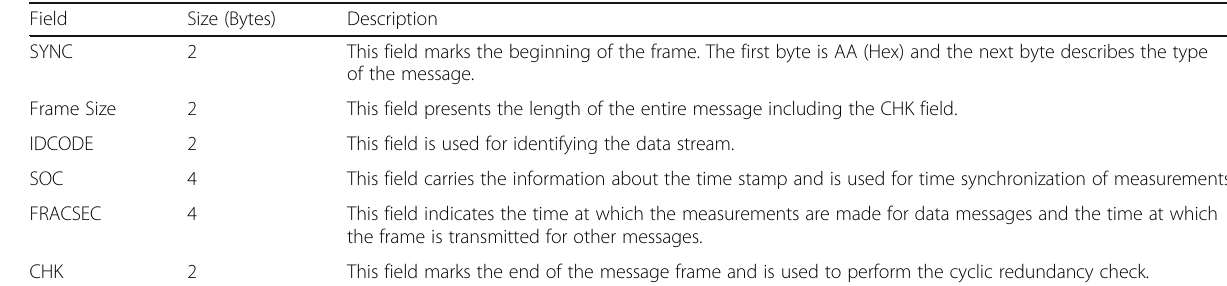
Table 2 Description of the Various Fields of the Message Frame Field